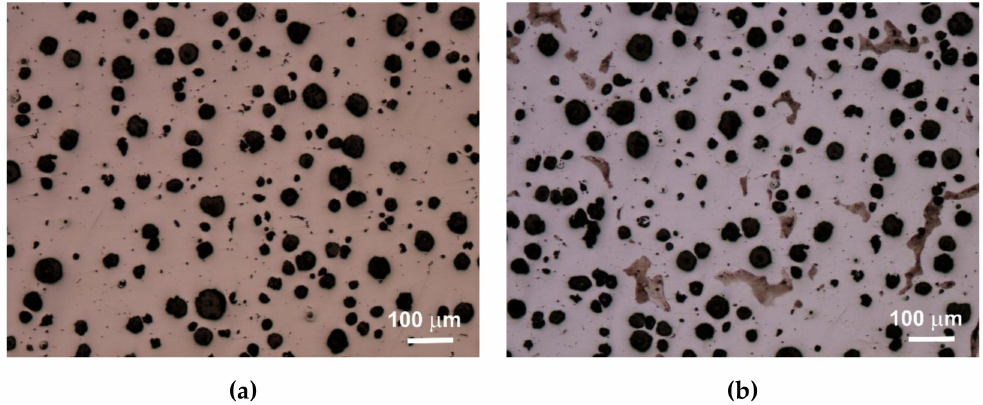
Figure 3. Microstructure of sample 1 non-etched ( a ) and etched ( b ).